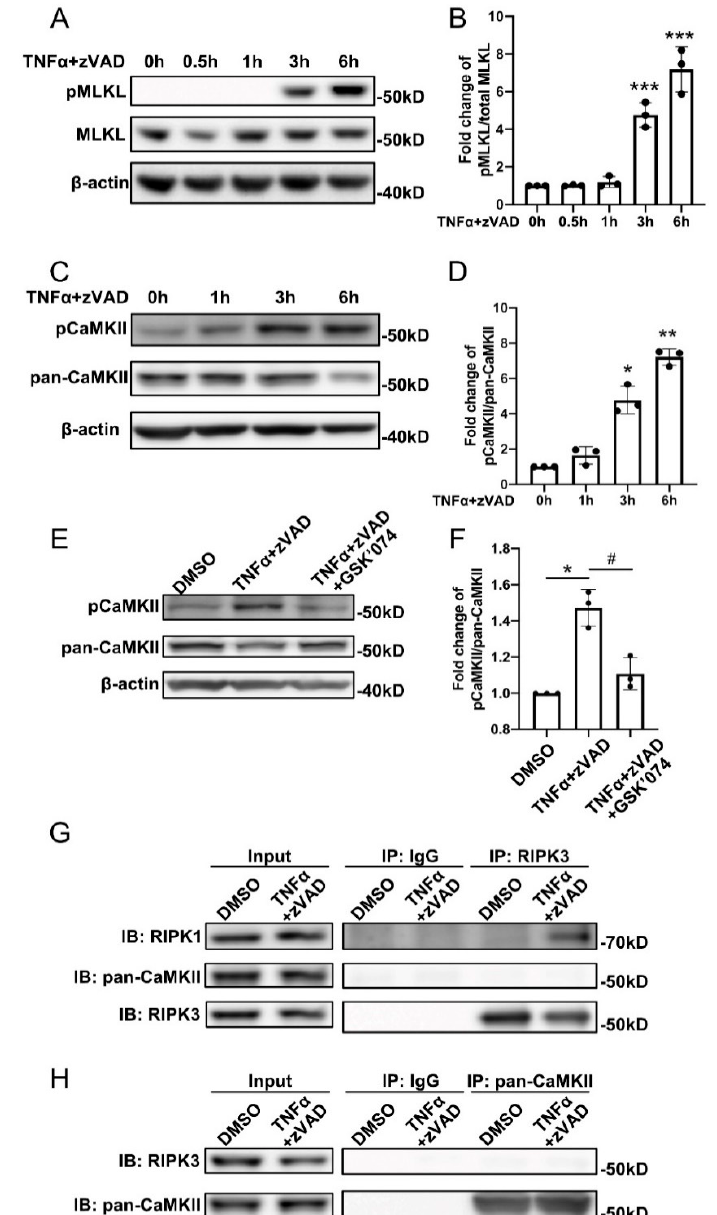
Figure 2 . Both MLKL and CaMKII are activated during SMC necroptosis . ( A , C ) Mouse aortic smooth muscle cells (MOVAS) were treated with 30 ng/mL TNF α plus 60 μ M zVAD for the indicated time period. Cells were lysed in RIPA buffer and analyzed by Western blotting with the indicated antibodies. ( B ) Quantification of ( A ). n = 3 for each timepoint. ( D ) Quantification of ( C ). n = 3 for each timepoint. ( E ) MOVAS were treated with 30 ng/mL TNF α plus 60 μ M zVAD for 6 h in the presence or absence of 10 nM GSK’074. Cells were lysed in RIPA buffer and analyzed by Western blotting with the indicated antibodies. ( F ) Quantification of ( E ). n = 3. ( G , H ) MOVAS cells were treated with 30 ng/mL TNF α plus 60 μ M zVAD for 6 h. Cell lysates were immunoprecipitated with anti-IgG, anti-RIPK3 ( G ), or anti-pan CaMKII ( H ) antibodies followed by Western blotting analysis with the indicated antibodies. Data were presented as mean ± SD of at least three independent experiments. One-way ANOVA was performed in ( B ), ( D ), and ( F ). * p < 0.05, ** p < 0.01, *** p < 0.001. In ( F ), * p < 0.05, compared with DMSO group; # p < 0.05, compared with TNF α +zVAD group.